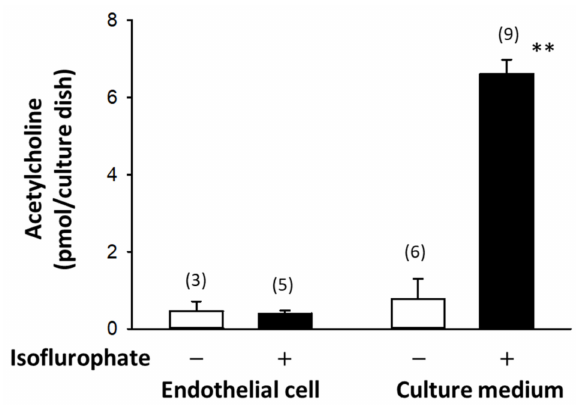
Figure 1. Synthesis and release of ACh in bovine arterial endothelial cells cultured for 24 h with or without isoflurophate. Isoflurophate strongly protected ACh from degradation. ** p < 0.01 vs. the value obtained in the absence of isoflurophate. Bars indicate means standard error of means. The numbers of samples are shown in parentheses. Rearranged from